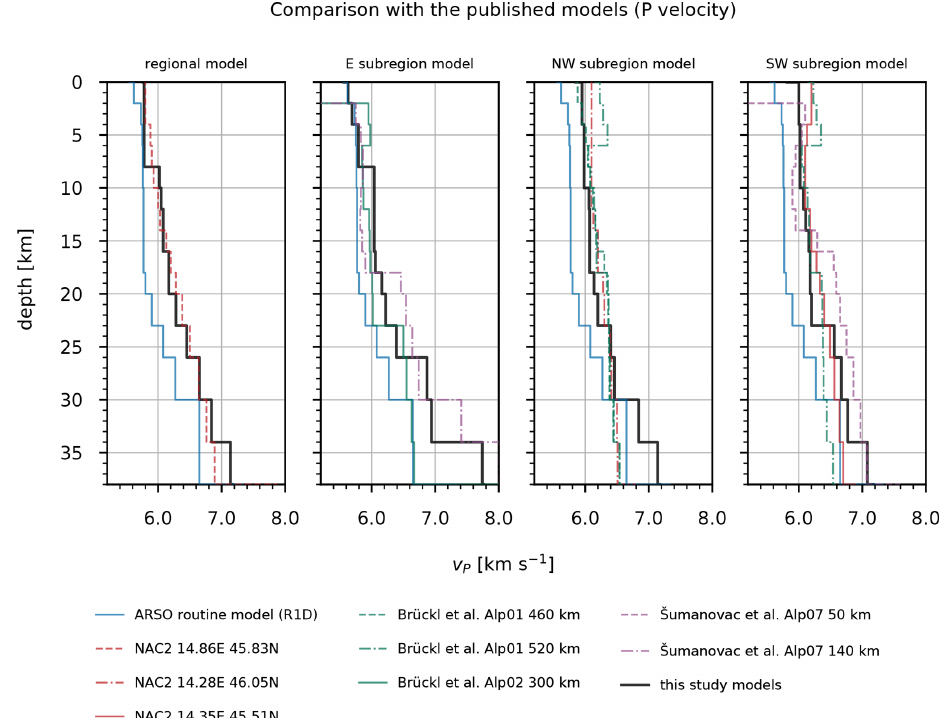
Figure 16. Comparison of the P velocities obtained in this study (black lines) with the published velocities of Brückl et al. (2007), Magrin and Rossi (2020), Šumanovac et al. (2009), and the routine (R1D) model. Models based on the results of Magrin and Rossi (2020; NAC2) were extracted at the point closest to the respective reference seismic station. Kilometers denote the distance along the profiles in Brückl et al. (2007) and Šumanovac et al. (2009). For easier comparison, all published models were extracted by calculating the weighted average of the velocities in each